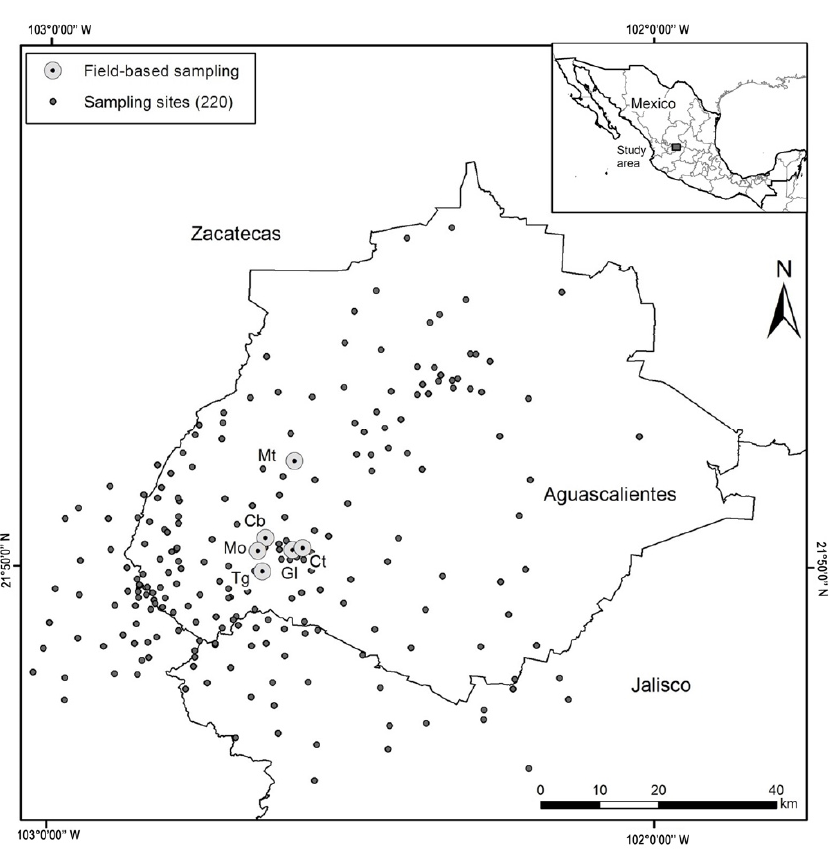
Figure 1. Study area in the central region of Mexico (220 sampling sites) and distribution of field- based sampling in the Aguascalientes State. Mt: Barranca Montoro; Cb: Presa Cebolletas; Mo: Presa Malpaso; Tg: Barranca Tortugas; Gl: Río Gil; and Ct: Puente Cuates.